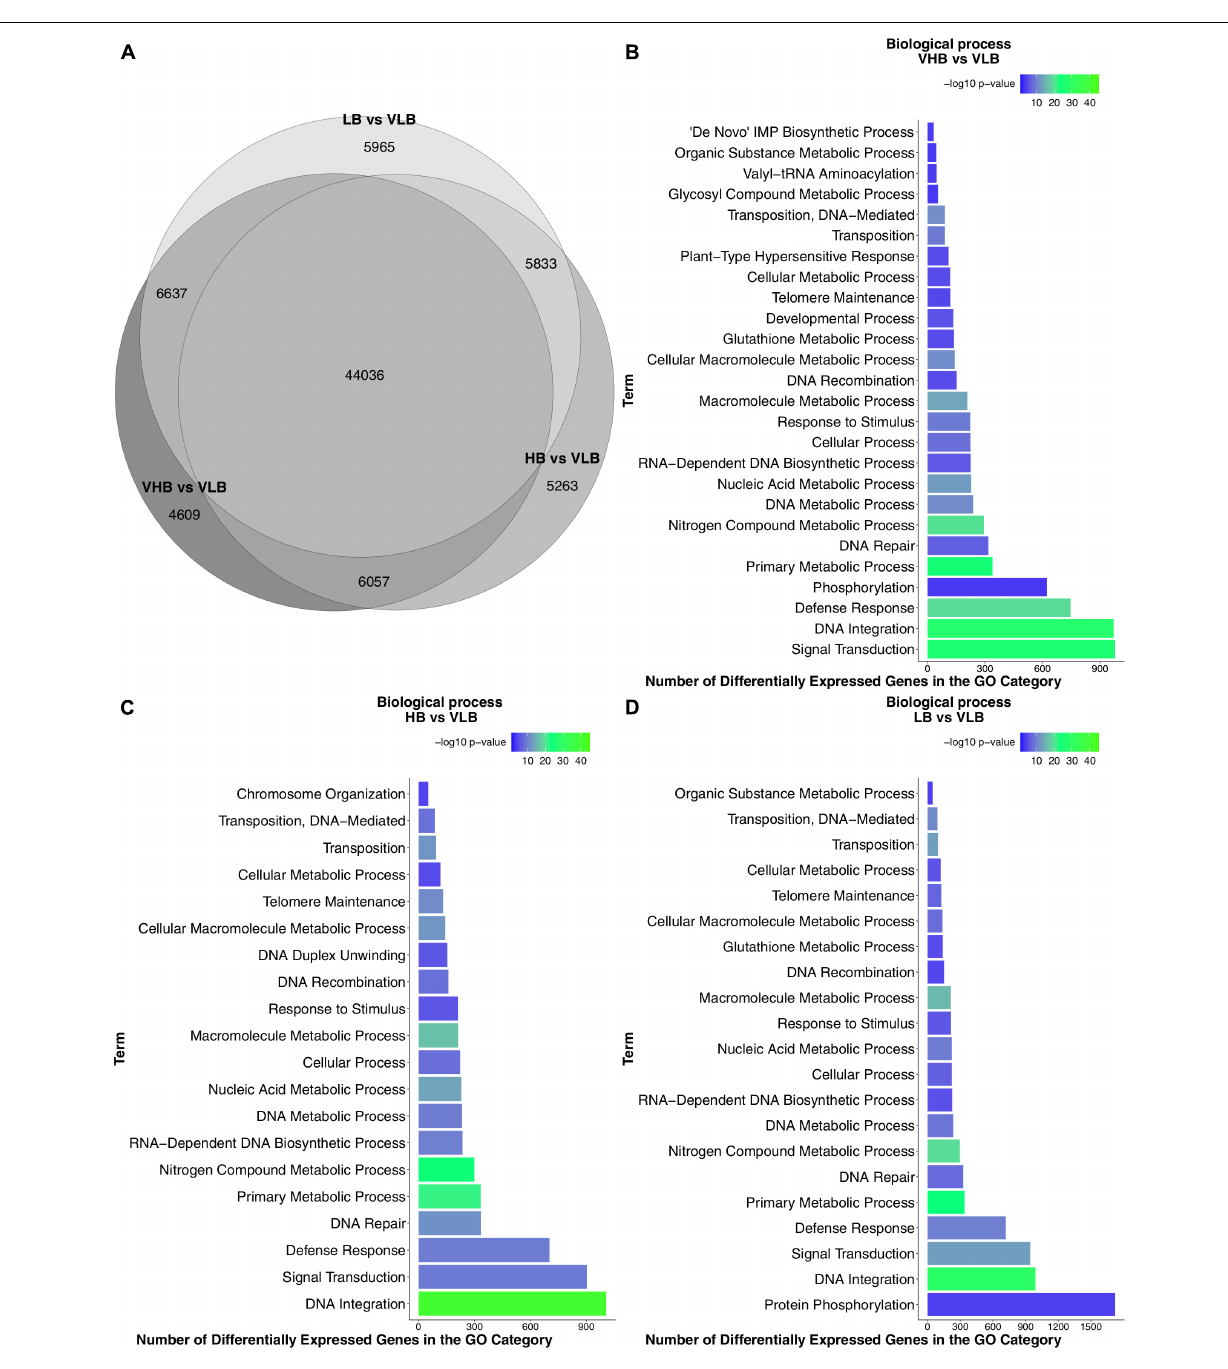
fructose and UDP-Glu, which are used for respiration and as cell wall components (Verma et al.,